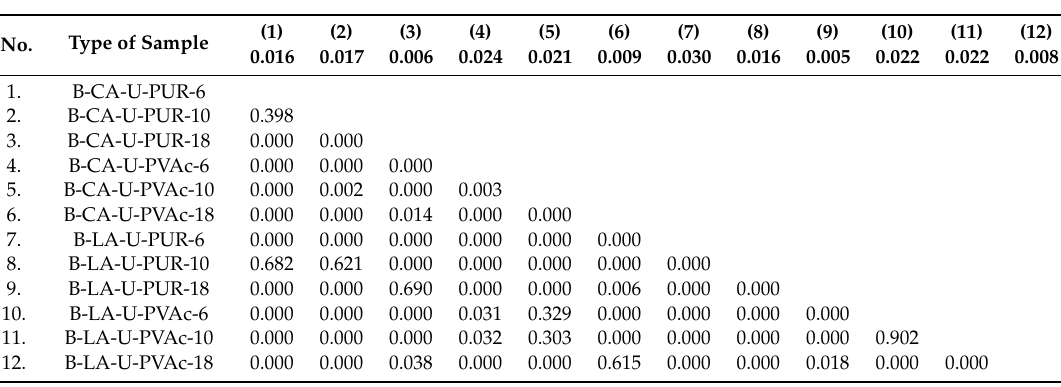
Table 26. Comparison of the e ff ects of individual factors using Duncan’s test on the coe ffi cient of bendability ( K bendB ) for beech and NWC on top.